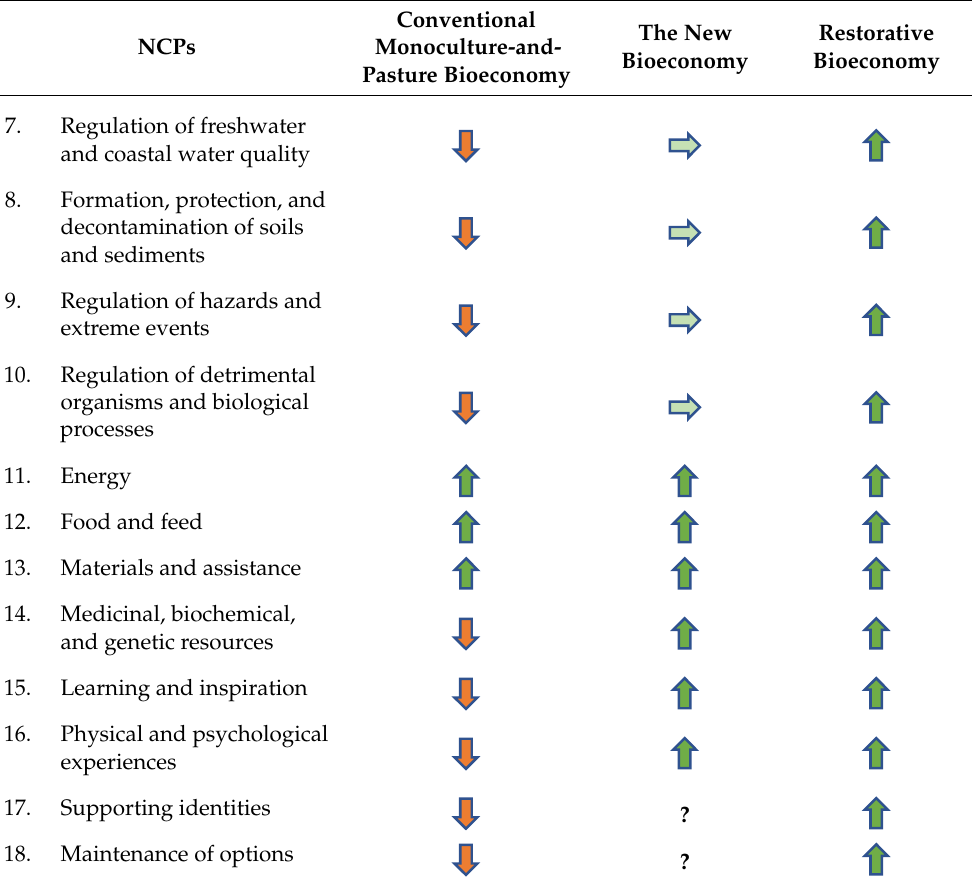
Supporting identities